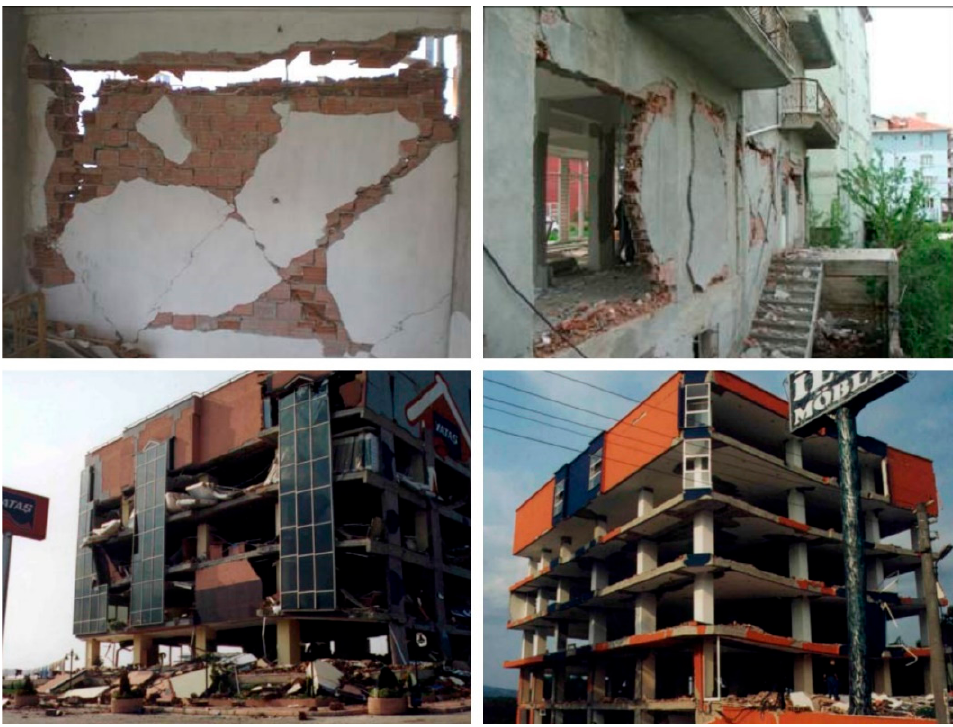
Figure 1. Infill wall damages from Simav, 2011, ( top ) [5] and Kocaeli, 1999, ( bottom ) [4] earth-